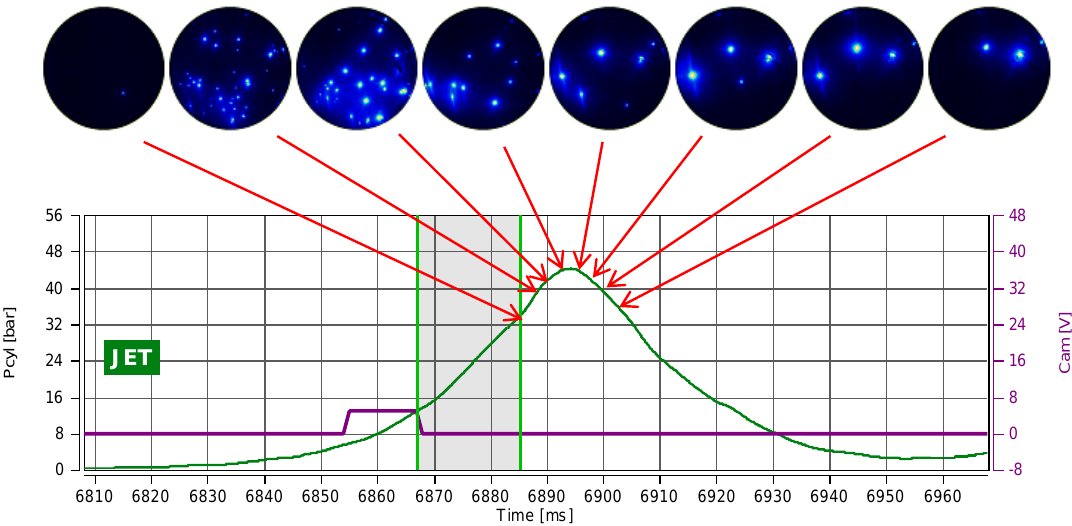
Figure 15. Location of the autoignition spots on the indicator graph during the combustion of the JET fuel (dt for the images: 2.5 ms).